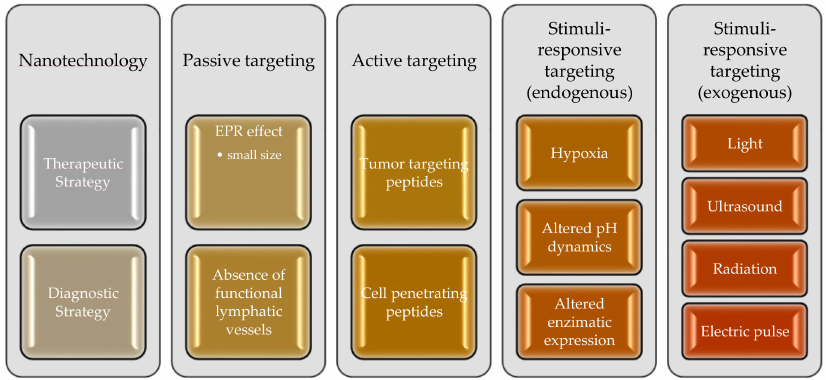
Figure 7. Strategies to enhance the permeability of the blood–brain barrier for treatment of